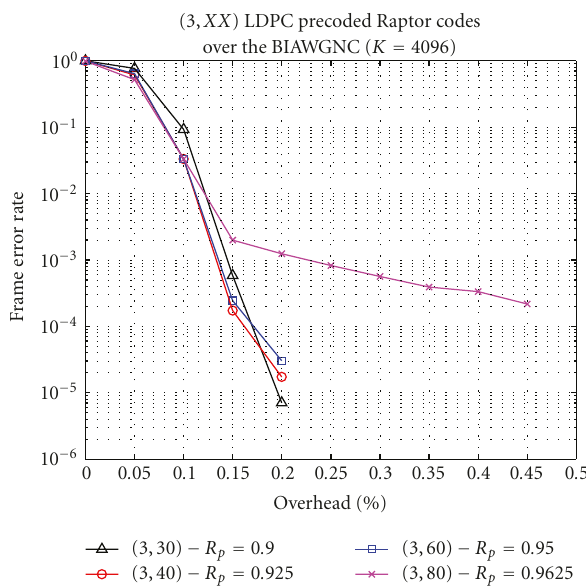
Figure 9: Performance of LDPC precoded Raptor codes of size K = 4096 The precode of highest rate R p = 0 . 9625 exhibit a severe error floor behavior.